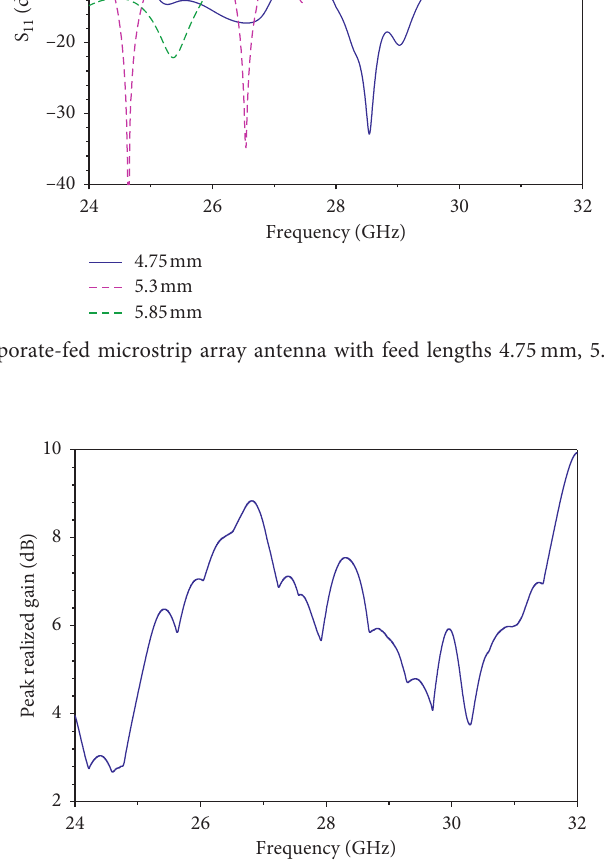
Figure 8: Peak realized gain of corporate-fed microstrip array antenna.